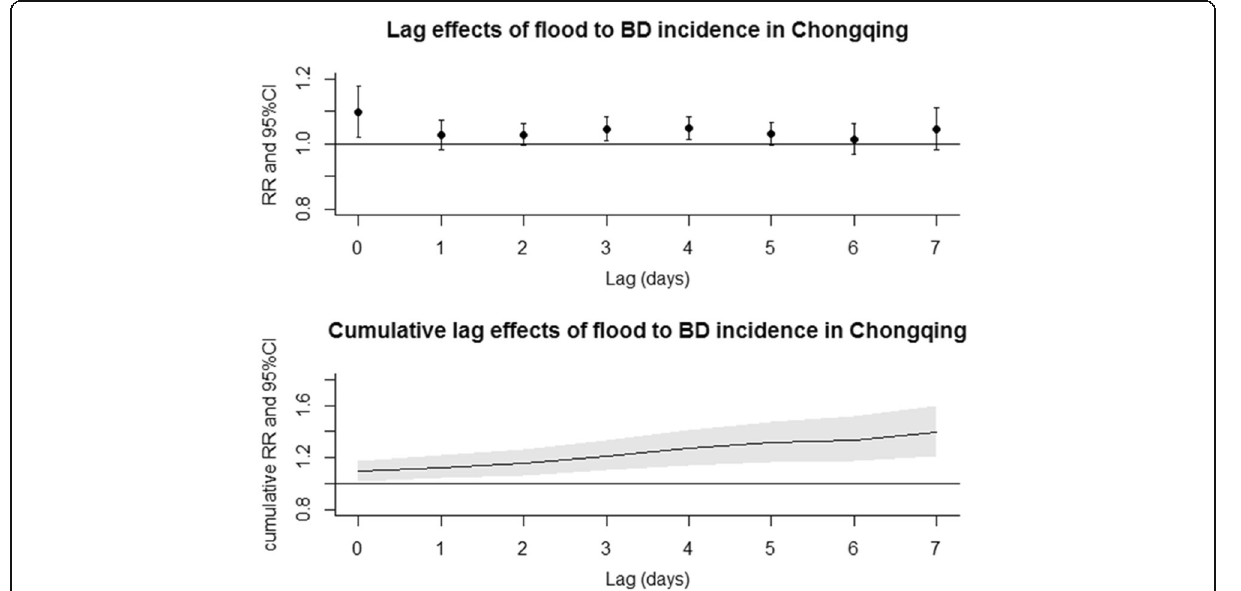
Fig. 2 Distributed lag non-linear effects of floods to bacillary dysentery incidence in Chongqing